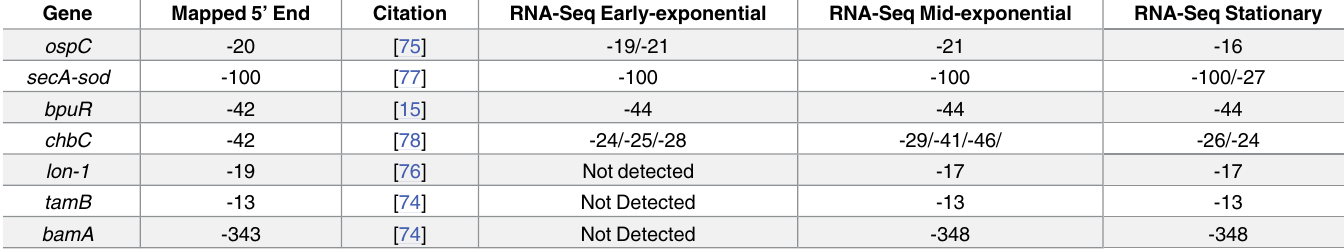
Table 2. Comparison of predicted transcriptional start sites with previously identified transcriptional start sites. Comparison of genes with previ- ously identifiedtranscriptional start sites that were also identifiedby RNA-Seq. Columnslist the gene, the previously-mappedstart-site location, citation for that determination, and RNA-Seqdetermined sites duringearly-exponential,mid-exponential, and stationaryphasesof growth.For some operons,RNA-Seq algorithmsidentifieddifferent start sites from different cultures; in which case, all called start sites are listed. Gene Mapped 5’